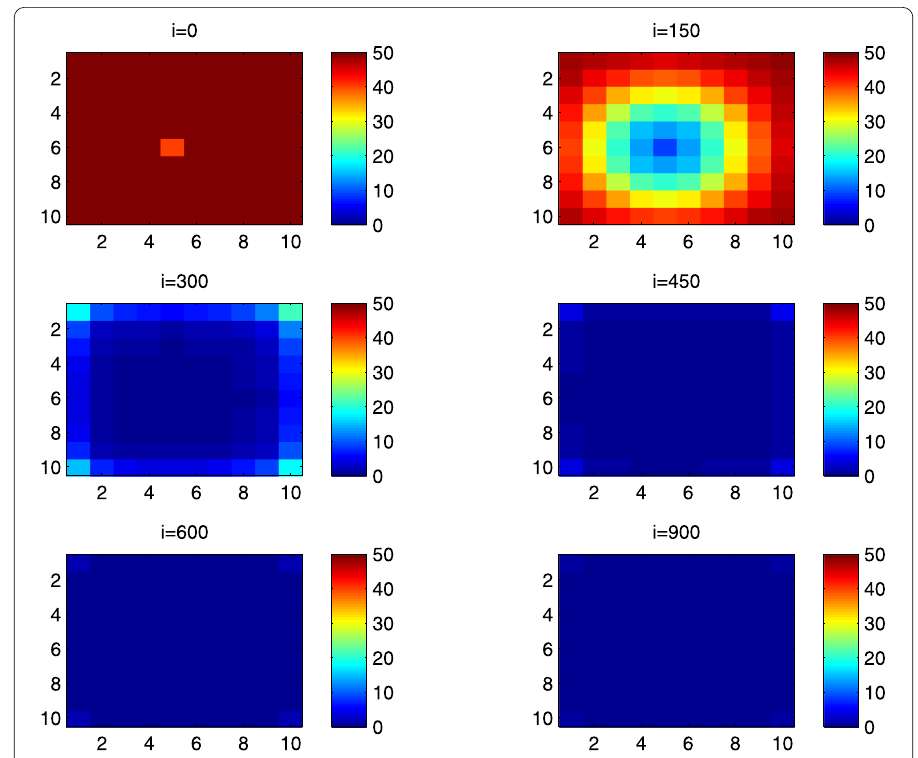
Figure 3 S Cpq behavior in the absence of control. The case when the disease starts from the center of (cid:2) .